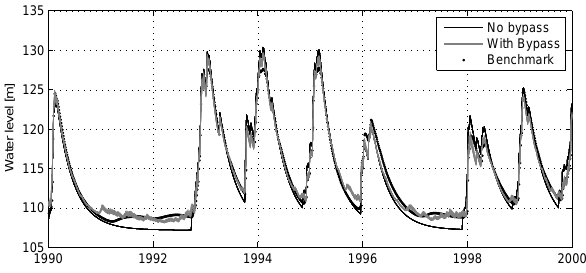
Fig. 7. Optimal water table simulations with the simple model with and without bypass